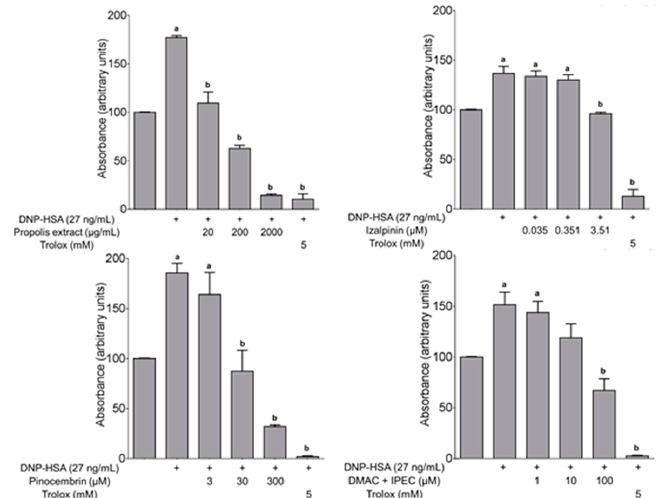
Figure 6. The inhibition of ROS production in stimulated mast cells. DMAC + IPEC mixture